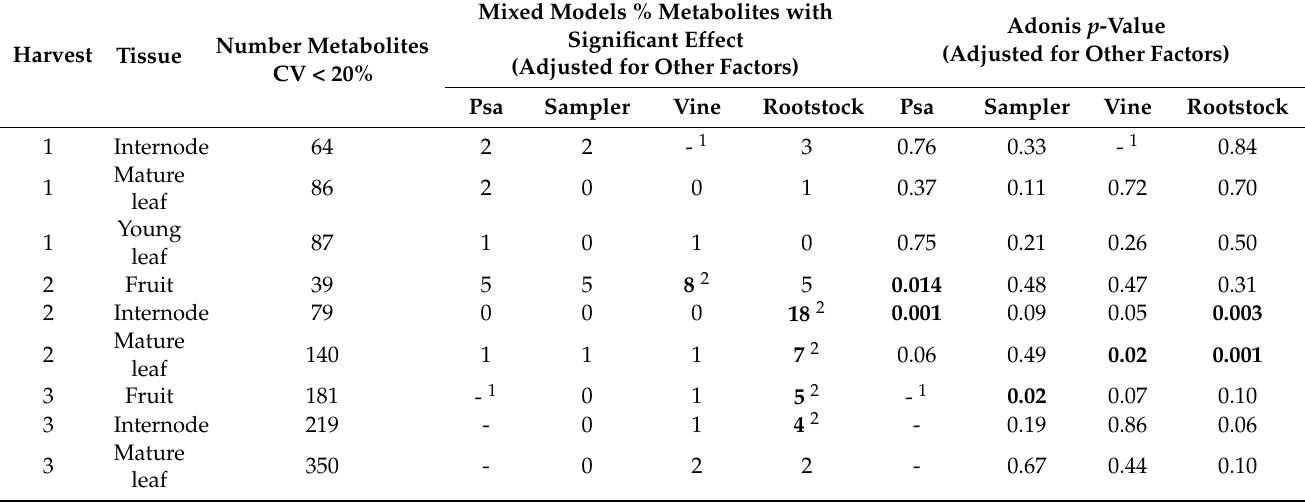
Table 4. Comparison of results from ANOVA and Adonis analysis of effects of Pseudomonas syringae var. actinidiae (Psa), sampler, between vine variation and rootstock on variability of metabolomics analysis of ‘Zesy002’ kiwifruit tissues collected at three harvest times. Values in bold show more significant effects than expected by chance (ANOVA) or p < 0.05 (Adonis).